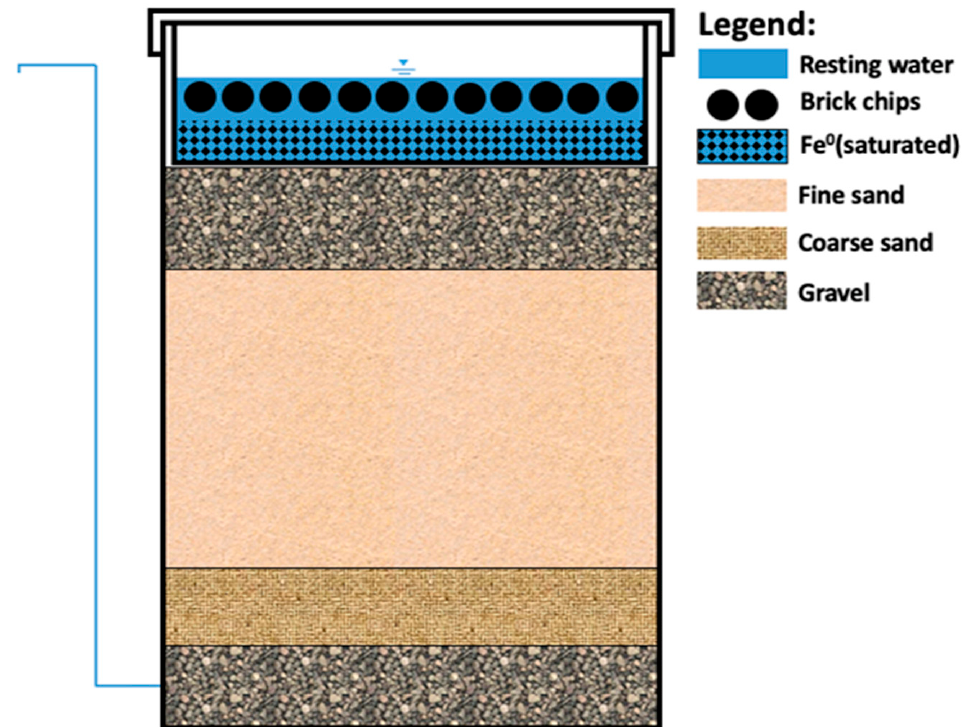
Figure 2. Diagram of a modified version of the original KAF to immerse the Fe 0 unit showing its components (modified after [30]). The total immersion of the Fe 0 unit is rendered possible by raising the outlet tap to above the level of the nail bed in the diffuser.